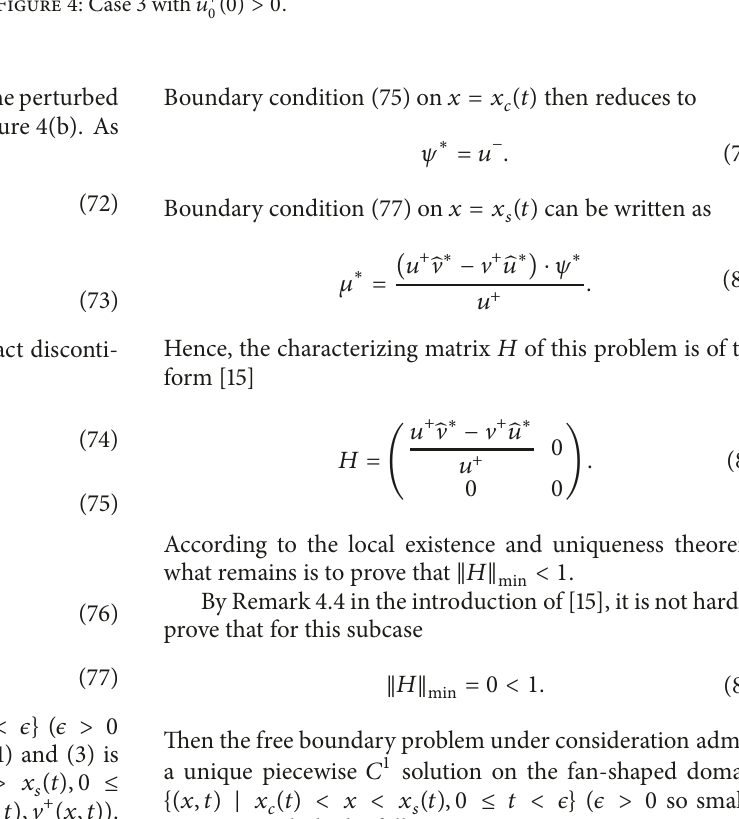
Figure 4: Case 3 with ̇𝑢 + 0 (0) > 0